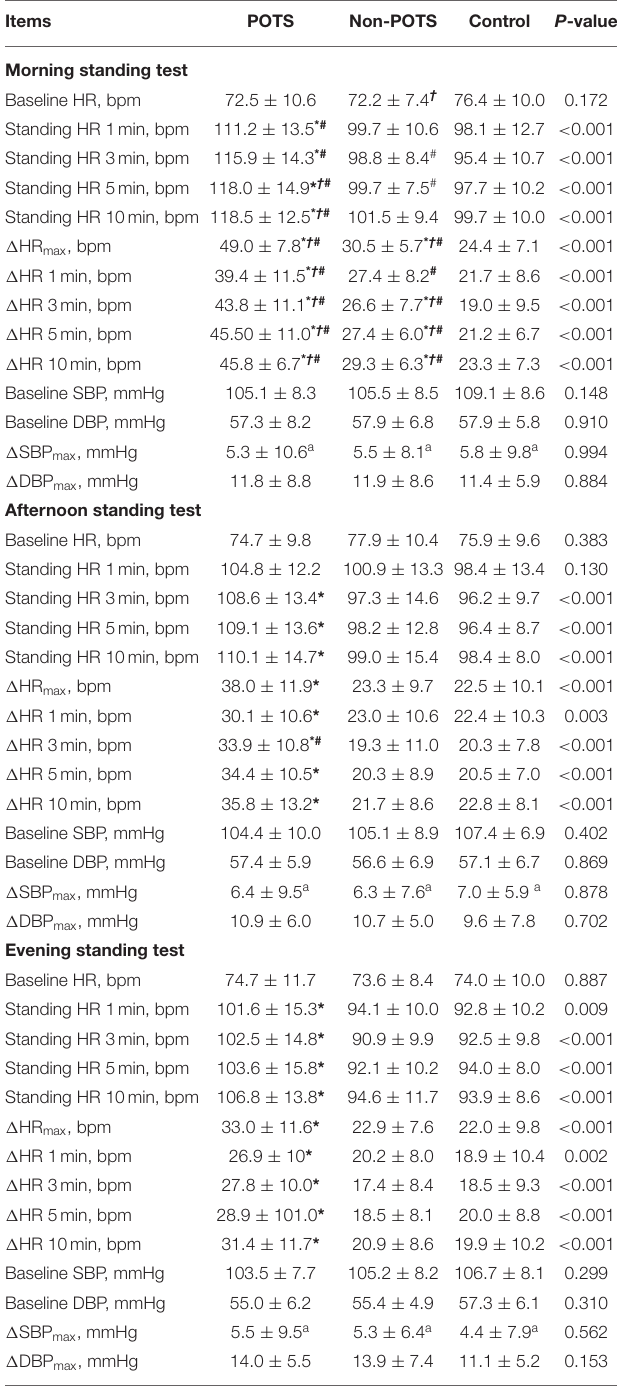
could be considered as POTS, combined with clinical